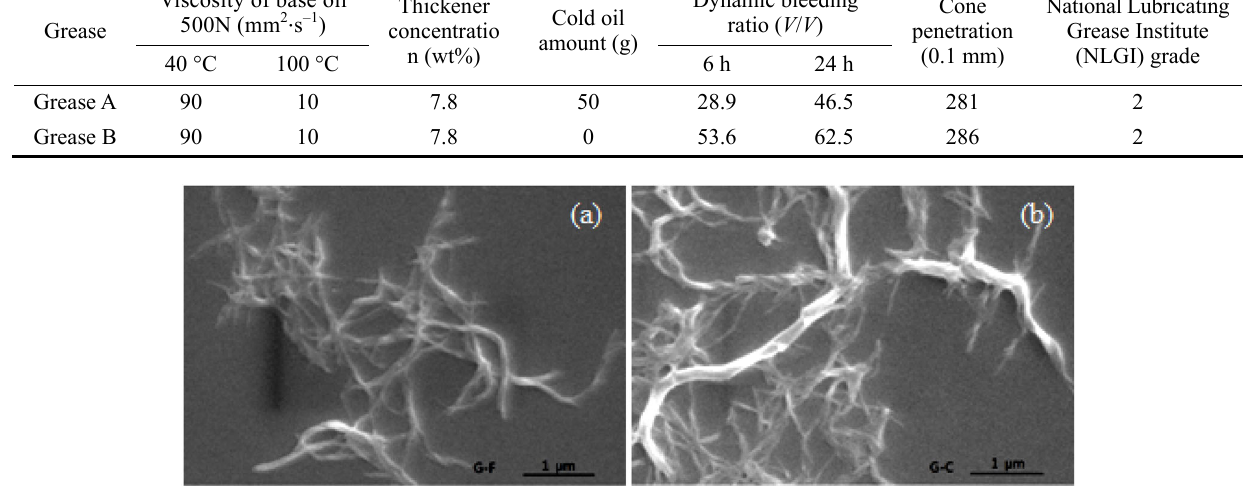
Fig. 2 SEM images of grease thickener fibers under different cooling rates: (a) Grease A and (b) Grease